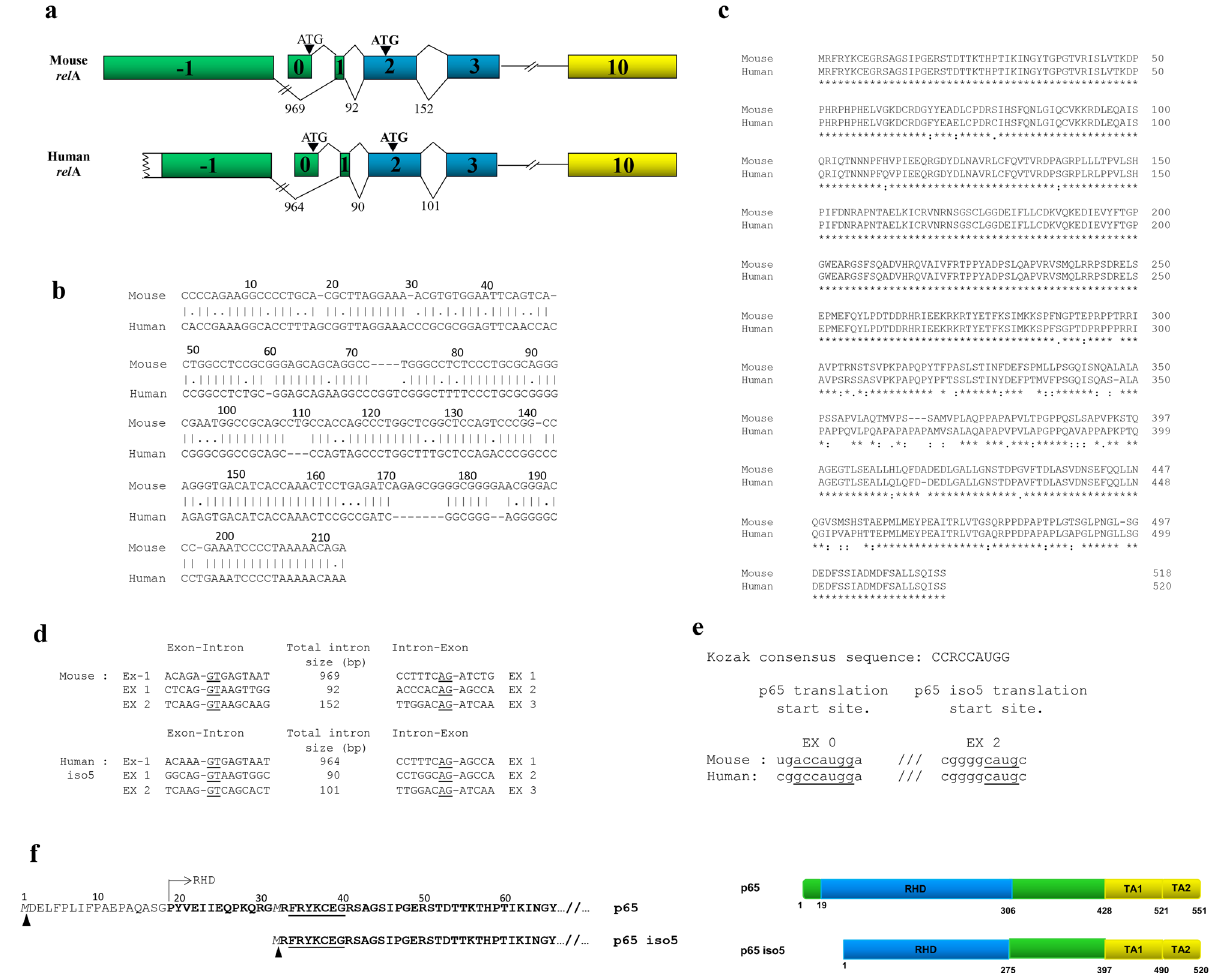
Figure 1. Organization of the murine and human relA gene, homology between amino acid sequences of human and mouse isoforms. ( a ) Partial genomic organization of the murine (GenBank accession number MN508964) and human (GenBank accession number MN508965) relA gene showing the alternatively spliced exon − 1. The lengths of the introns are indicated in base pairs and p65 iso5 start codon is indicated in bold. ( b ) Comparison of mouse and human exon − 1 partial sequences. ( c ) Alignment between amino acid sequences of p65 iso3 mouse and p65 iso5 human. The alignment was performed by using Clustal Omega tool (EMBL-EBI). ( d ) Exon–intron borders of part of the murine and the human relA gene. The intronic splice donor and acceptor sites are underlined. ( e ) Sequences surrounding p65 and p65 iso5 translation start site in mouse and human mRNA. The homology between Kozak consensus sequence of p65 and p65 iso5 are underlined. R indicate a purine (A or G). ( f ) Primary amino acid sequences of human p65 and p65 iso5 proteins. Underlined: